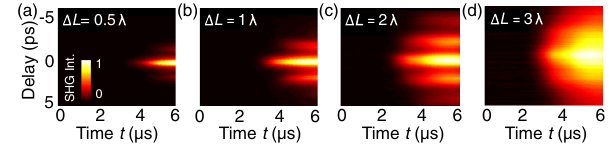
FIG. 8. Subpulse structure as seen by SHG auto-correlation measurements at different detunings Δ L . In the plots (a) – (d), only the beginning of the macropulse is shown, while the delay refers to the temporal overlap of the split micropulse. For shorter cavity lengths, more subpulses are formed until their overlap results in a single-peaked, broad micropulse.